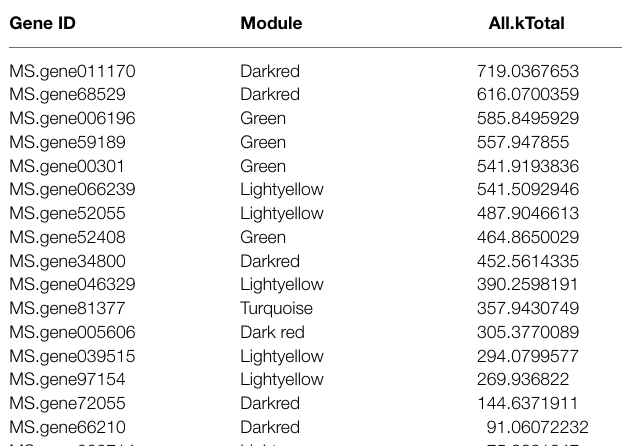
TABLE 2 | The results of overlapped genes between ABCC subfamily genes and differentially expressed genes (DEGs).